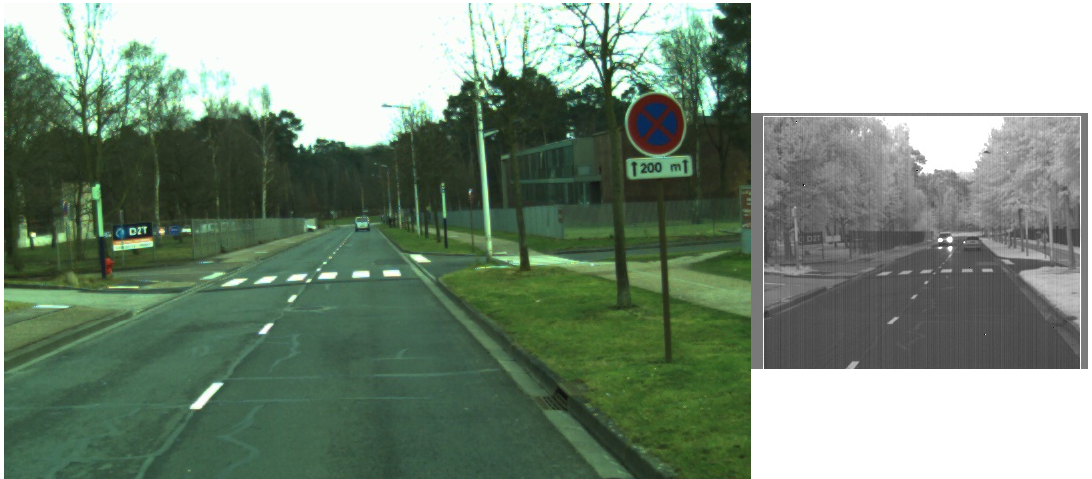
Figure 22. A Visible-SWIR pair from our dataset.